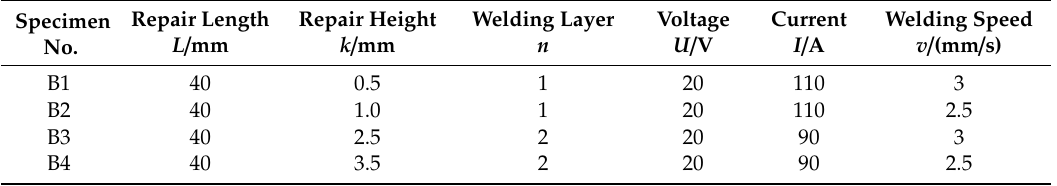
Table 2. Welding parameters of repaired specimens with different repair heights.